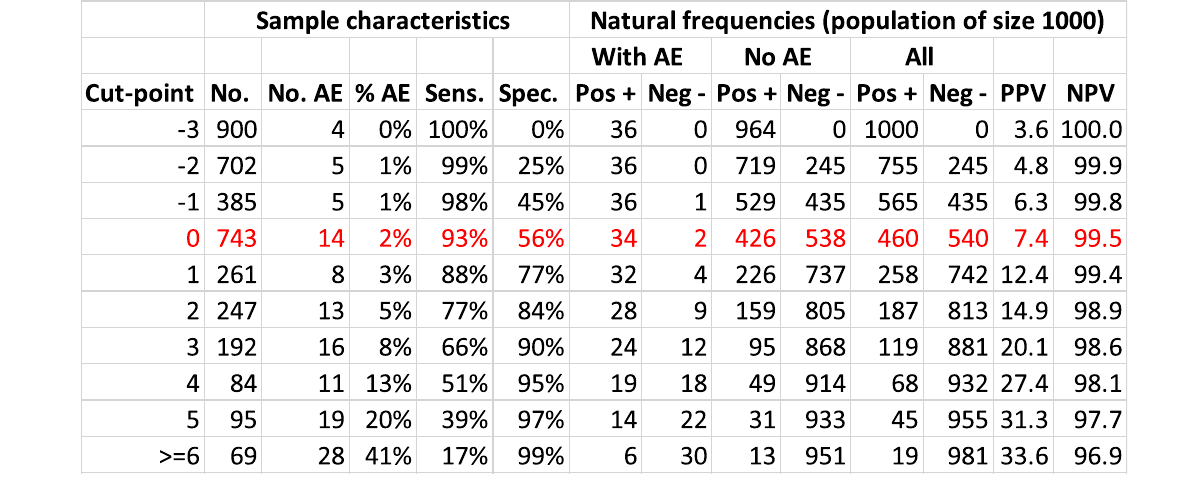
Table 2 Summary of performance measures across a range of cut-points for the Canadian Syncope Risk Score using natural